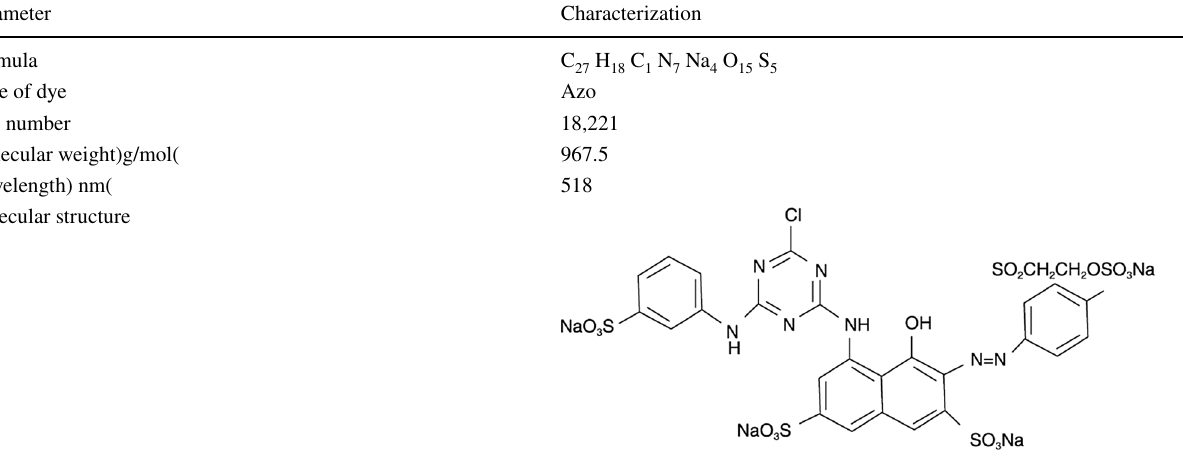
Table 1 The molecular structure and characteristics of RR-198 [8] Parameter